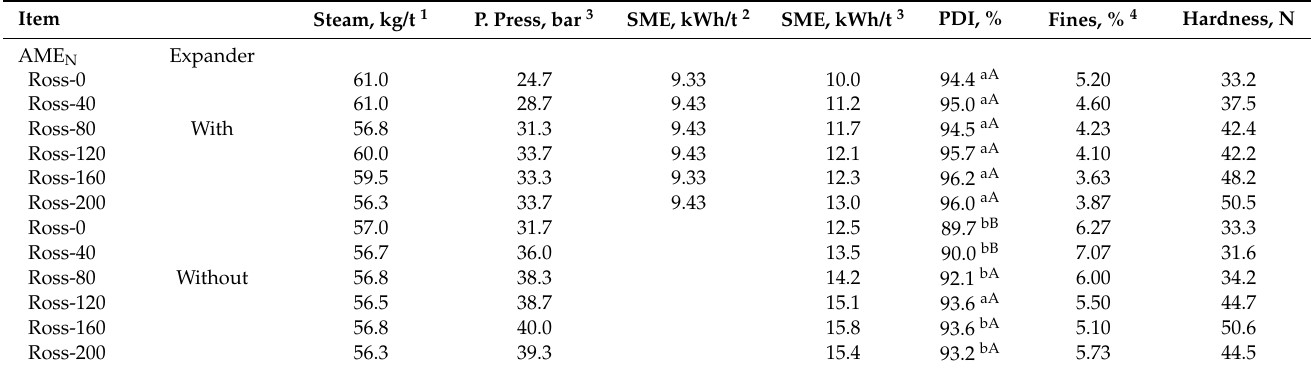
Table 5. Breakdown of significant interactions as presented in Table 4.